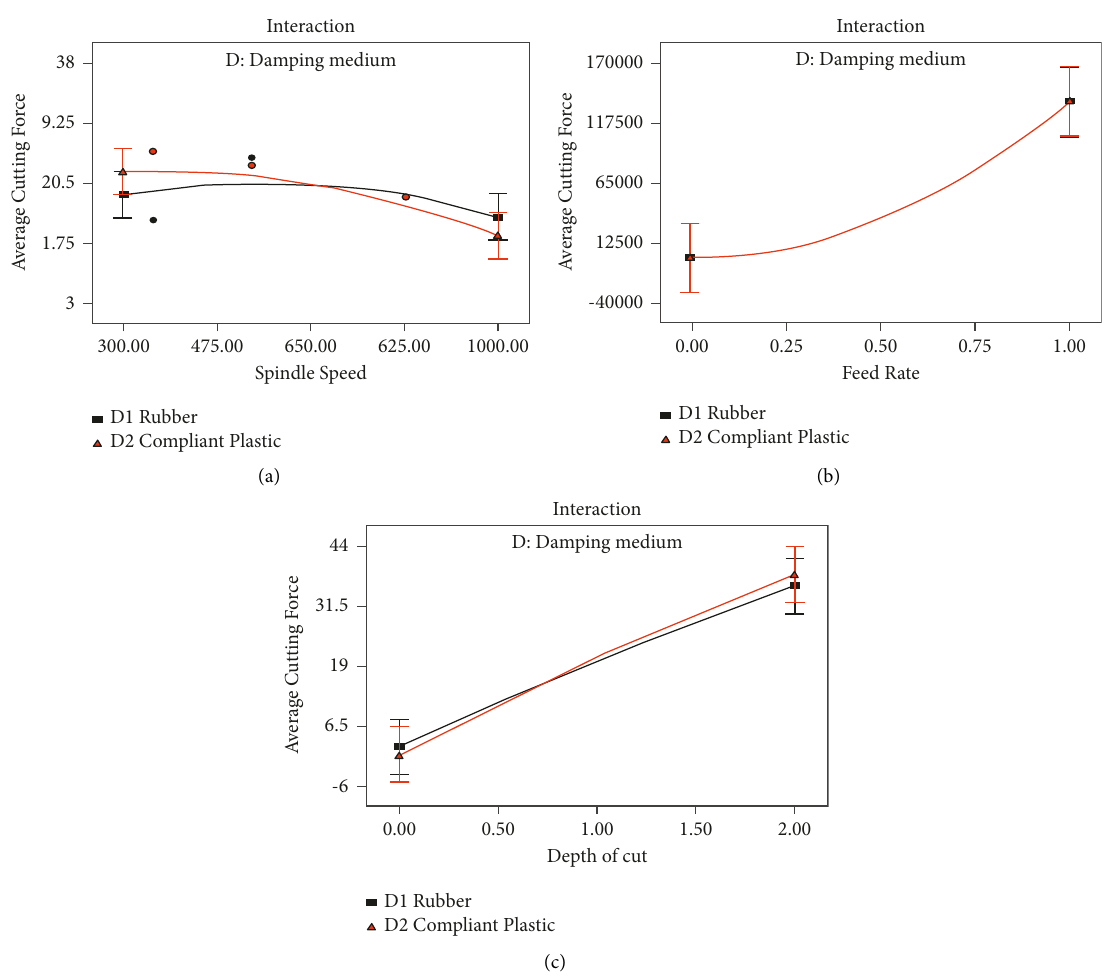
Figure 9: Interaction plots for average cutting force with machining parameters: (a) average cutting force vs. spindle speed, (b) average cutting force vs. feed rate, and (c) average cutting force vs. depth of the